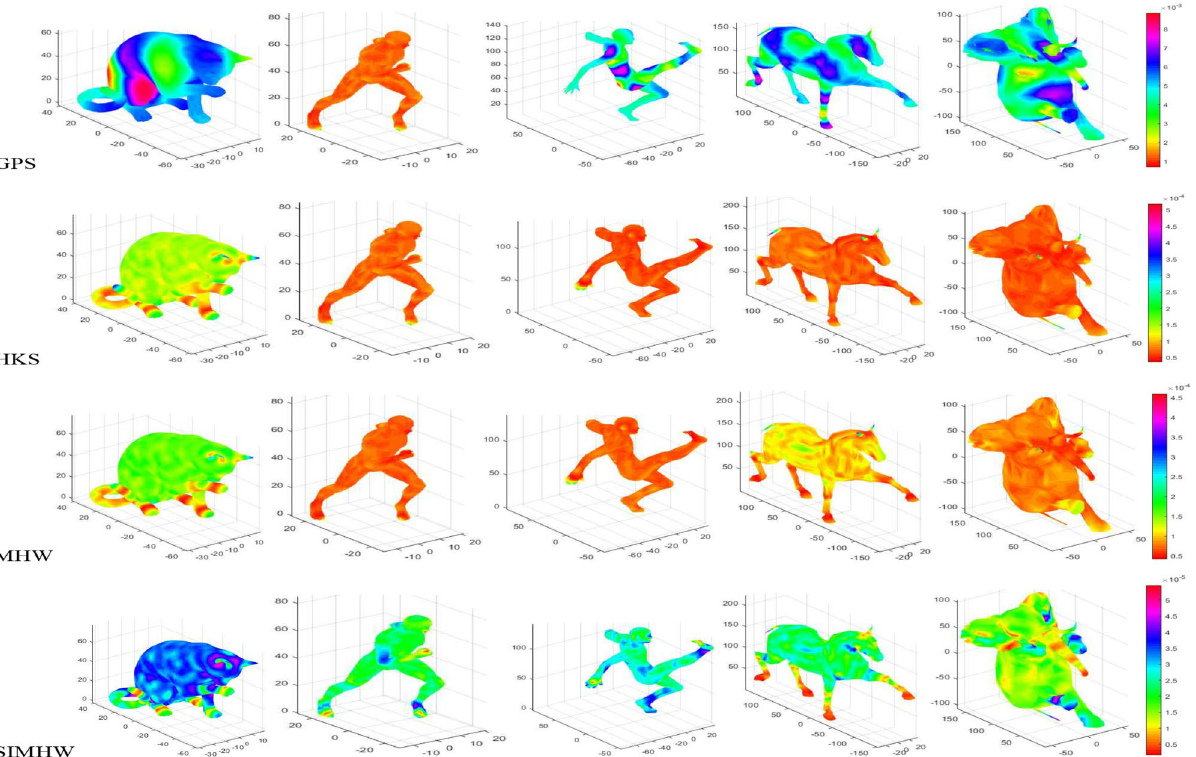
Figure 4. Description performance comparison of GPS, HKS, MHW and